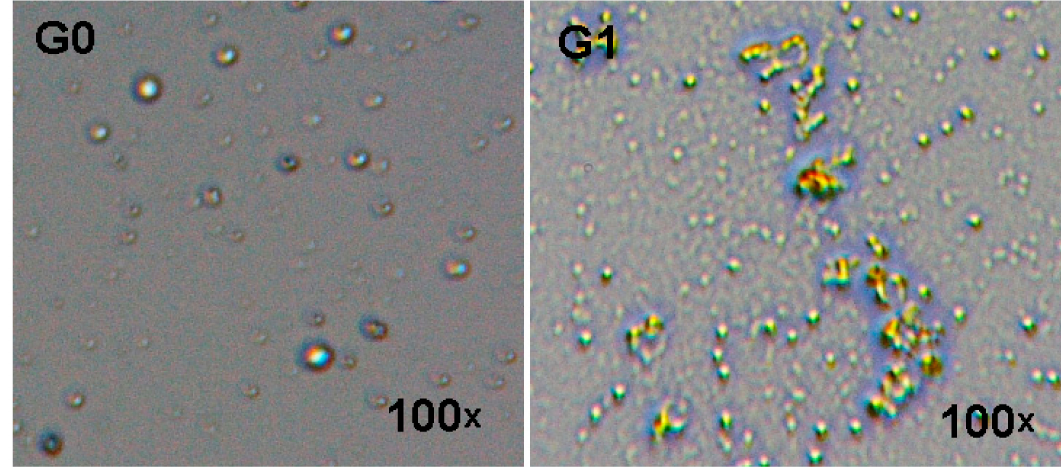
Figure 5. Optical microscope images of SiO 2 NPs (sample G0) and silica-gentamicin nanostructured solution (sample